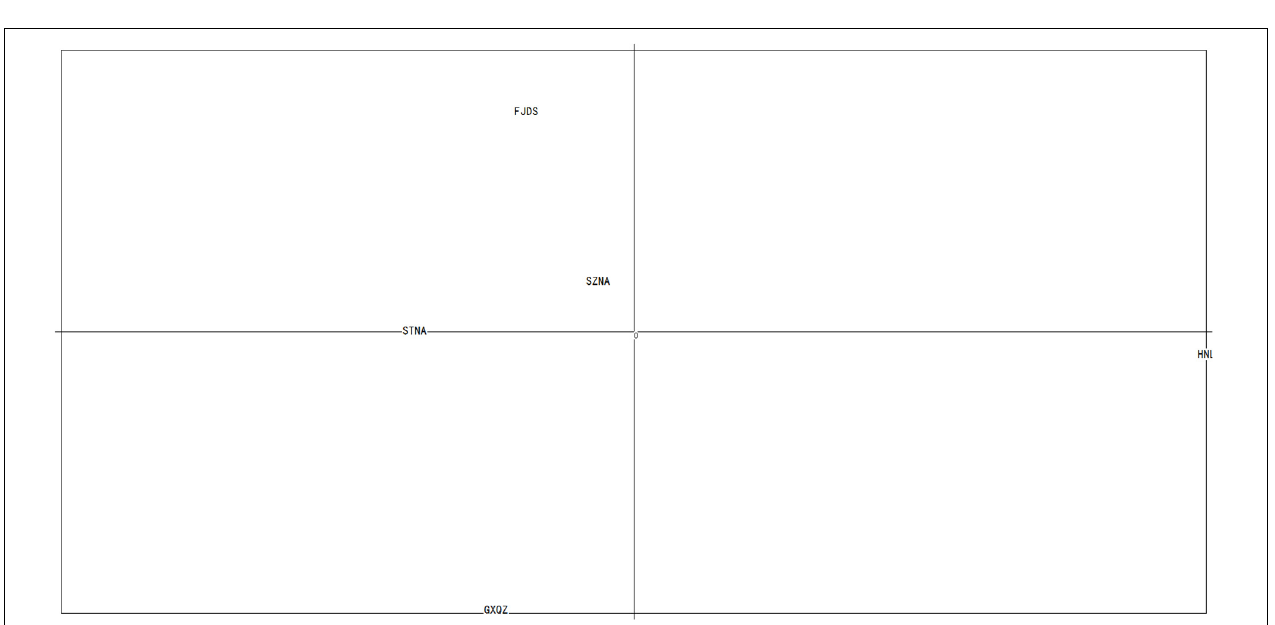
FIGURE 3 | UPGMA dendrogram showing the phylogenetic relationships among five samples of C. nobilis , based on a matrix of genetic distance (Nei, 1972). Bootstrap values are given for nodes at least 62% or more support.